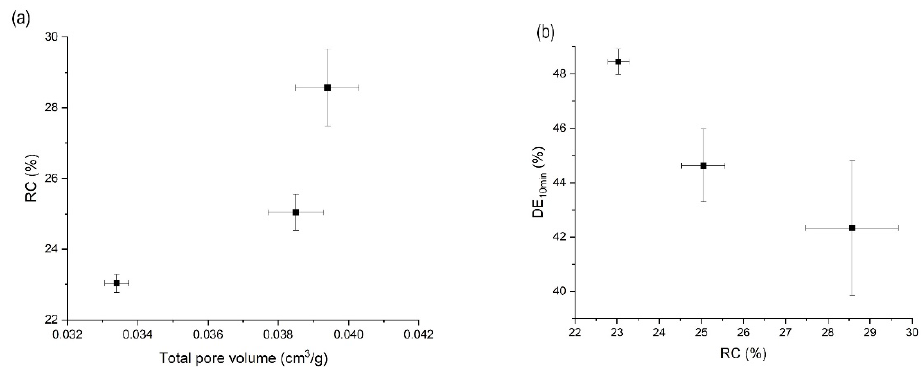
Figure 7. ( a ) Correlation between total pore volume and relative crystallinity (RC) and ( b ) correlation between RC and DE 10 for orlistat-loaded Neusilin ® UFL2 samples prepared by MA-SCF at various pressure with a constant temperature of 318.15 K.